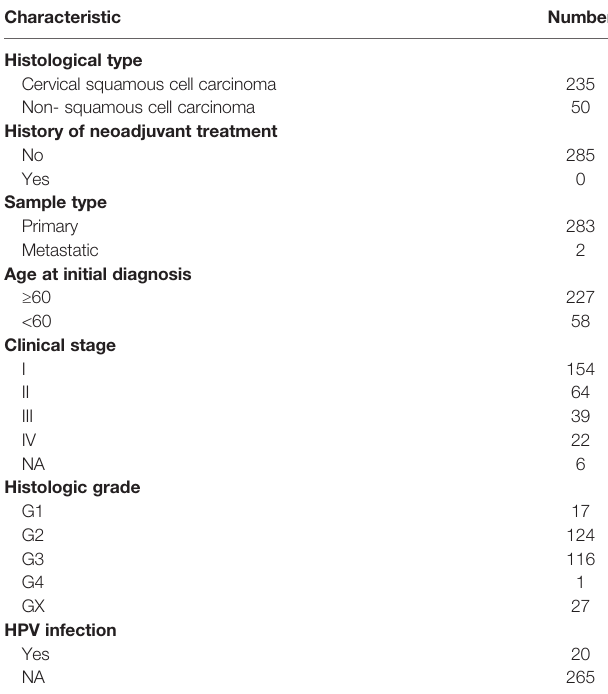
TABLE 1 | Clinicopathological parameters of patients with cervical cancer in our cohort in the study. Characteristic